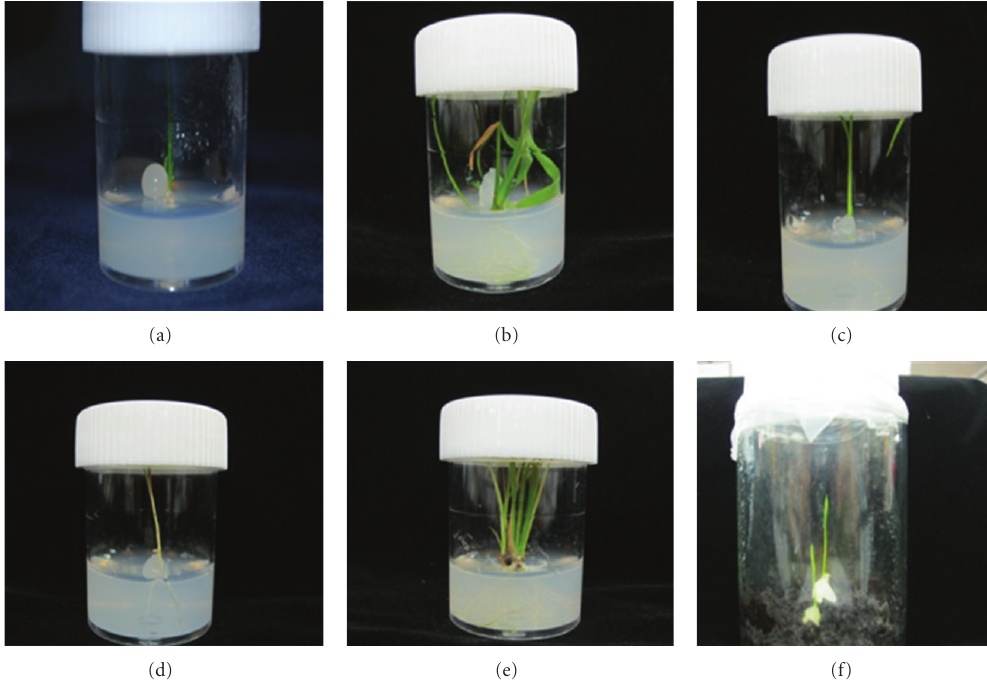
Figure 1: Synthetic seed germination on, (a) MS medium, two weeks old, (b) MS medium after one month, (c) MS medium + 0.1 mg/L BAP, (d) tap water + agar, (e) capsule matrix containing 0.1 mg/L BAP + 0.1mg/L NAA, (f) top soil + tap